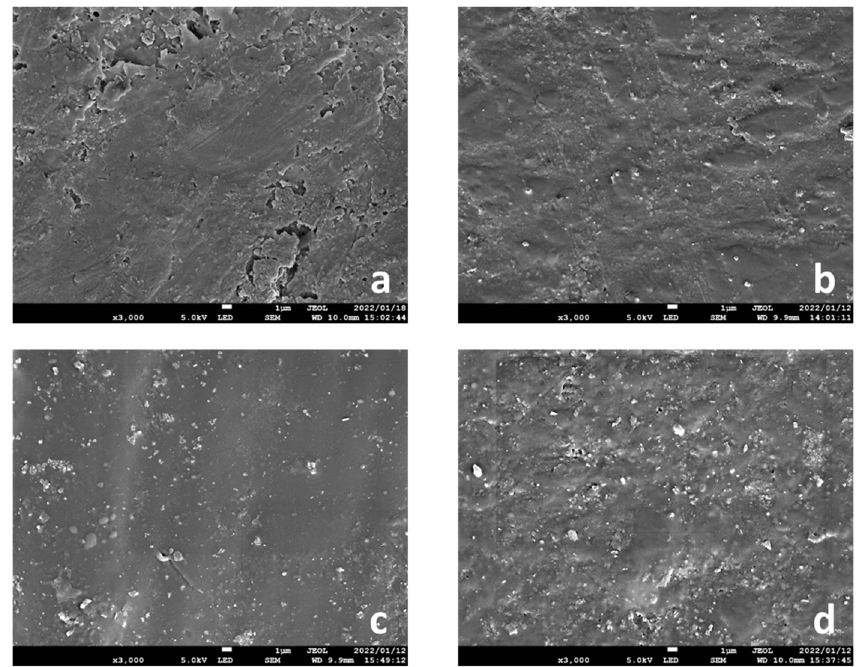
Figure 2. Distribution of zirconia filler under each condition (3000× microscope image). The zirconia filler was uniformly distributed in the photopolymer resin under each condition: ( a ) 0 wt.% (control), ( b ) 3 wt.%, ( c ) 5 wt.%, and ( d ) 10 wt.%. All images were captured when the printing direction was 0°.